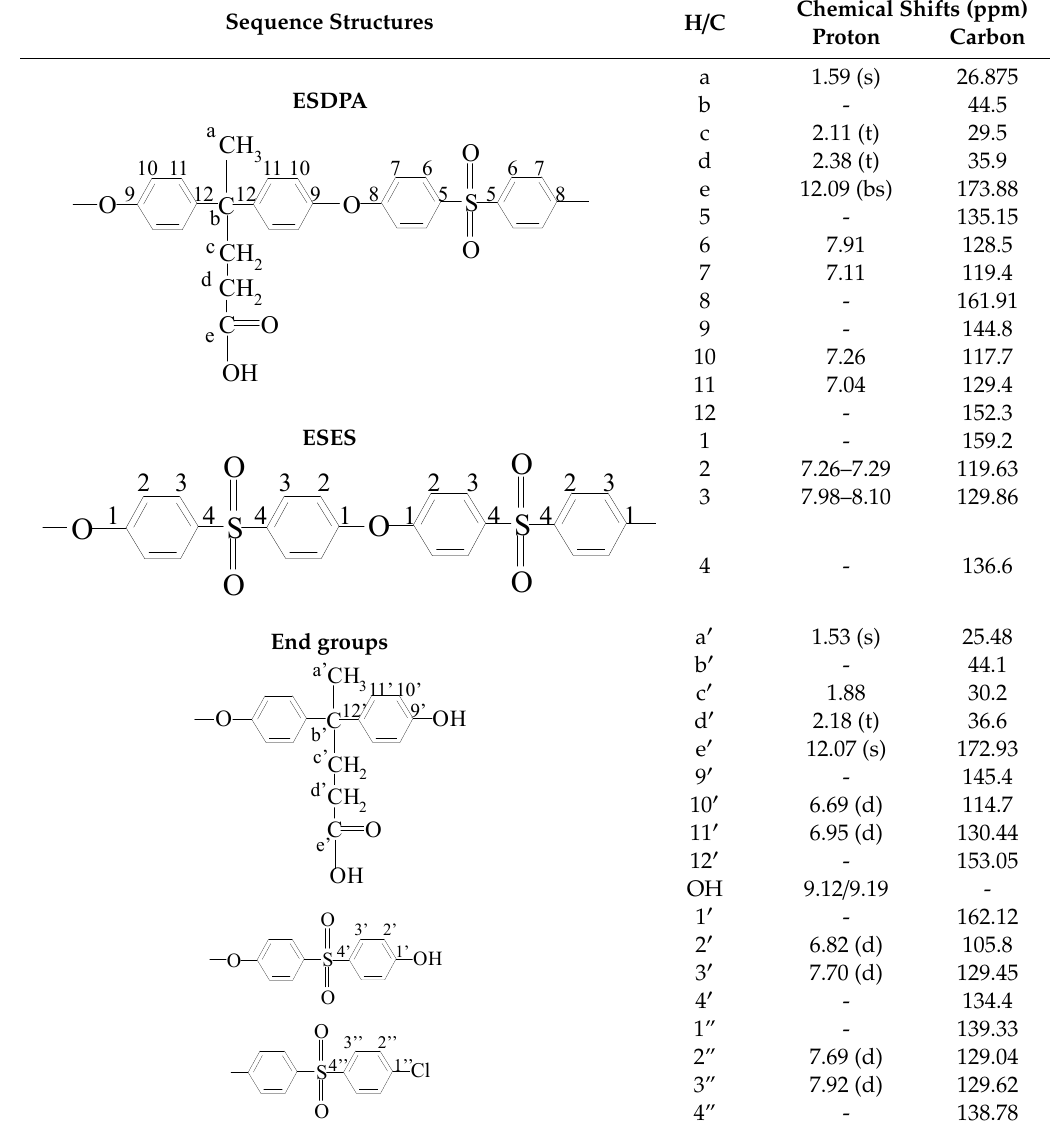
Table 2. Assignments, chemical shifts and integrations of signals observed in the spectra of the whole set of synthesized homopolymers.